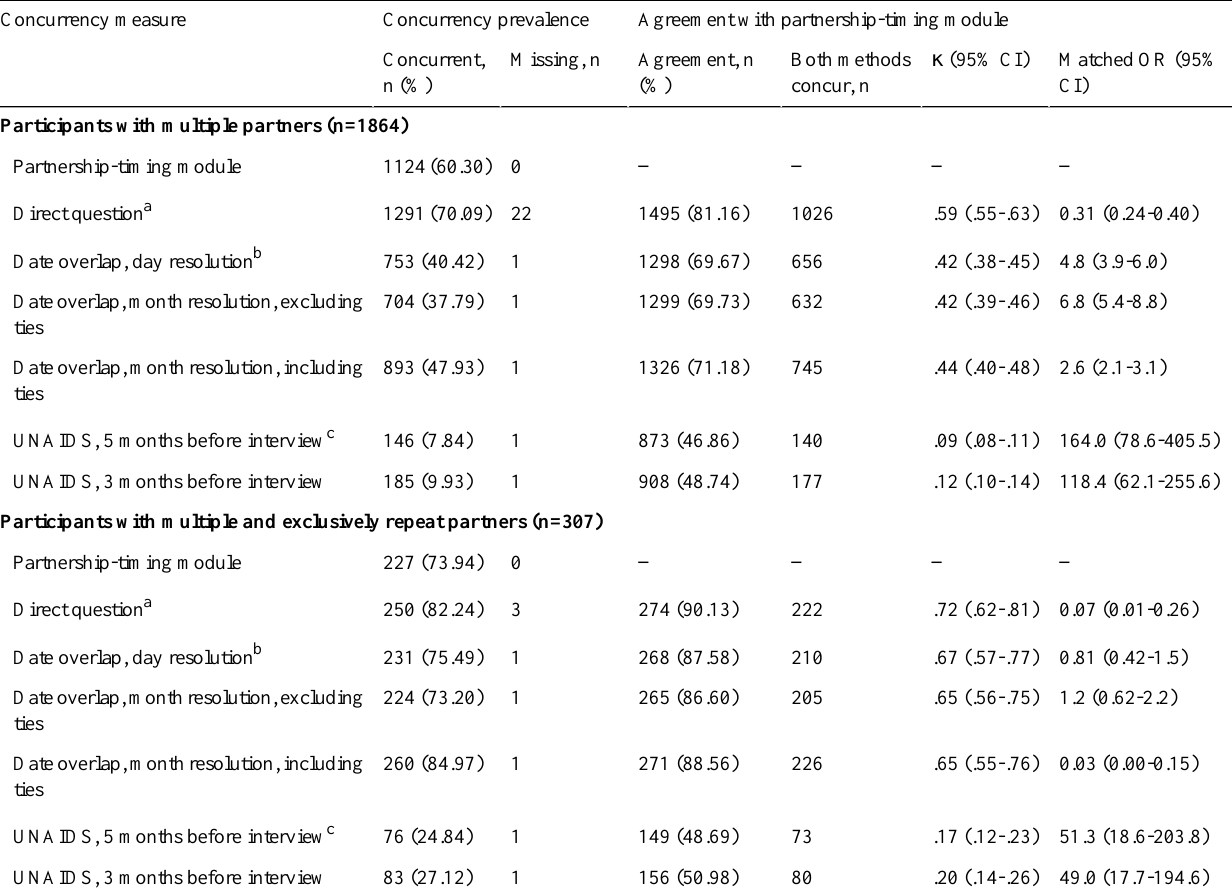
Table 2. Individual-level concurrency by partnership-timing module and alternative measures of concurrency among subsets of men who have sex with men.